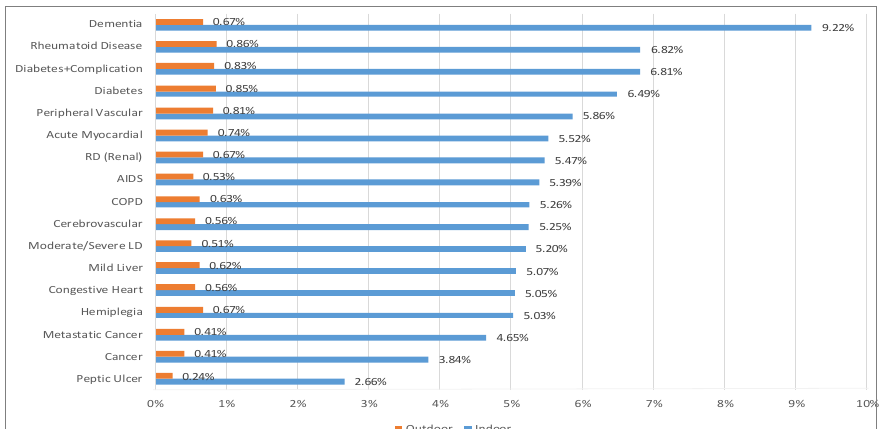
Figure 3 . Probabilities of an indoor and outdoor fall in the presence of a chronic condition, NEDS 2017. Note: The complement of the probabilities for each chronic condition is the probability associated with no fall in the presence of the respective chronic